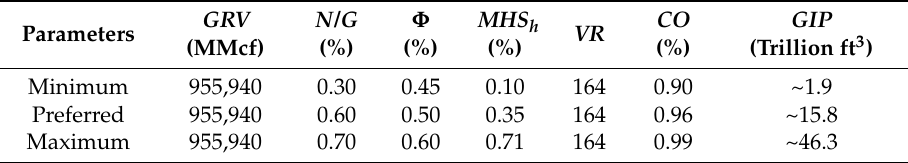
Table 1. Minimum, preferred, and maximum GIP estimates. The gross rock volume is obtained from our seismic interpretation of the thicknesses of the MHCZs. The net-to-gross ratio, porosity, and methane hydrate saturation values are obtained from C0002 borehole constraints. The void ratio assumes a pore filling GH structure, and the cage occupancy possibilities is from field observations around the world with 0.96 being most